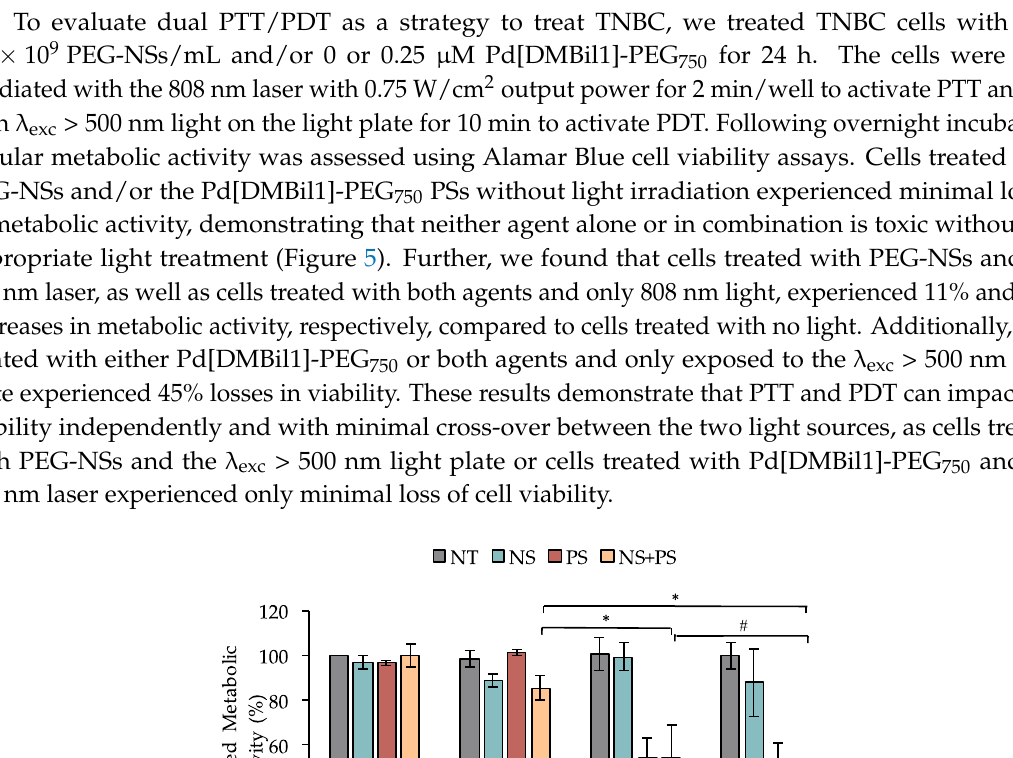
Figure 4. Fluorescence and darkfield images showing the binding and uptake of the Pd[DMBil1]-PEG 750 PSs and PEG-NSs, respectively, by MDA-MB-231 TNBC cells following a 24 h incubation period. Nuclei are blue (DAPI), F-actin in the cytoskeleton is green (phalloidan), and Pd[DMBil1]-PEG 750 is red. In darkfield microscopy, PEG-NSs are visualized as bright gold spots. Scale = 25 μm.